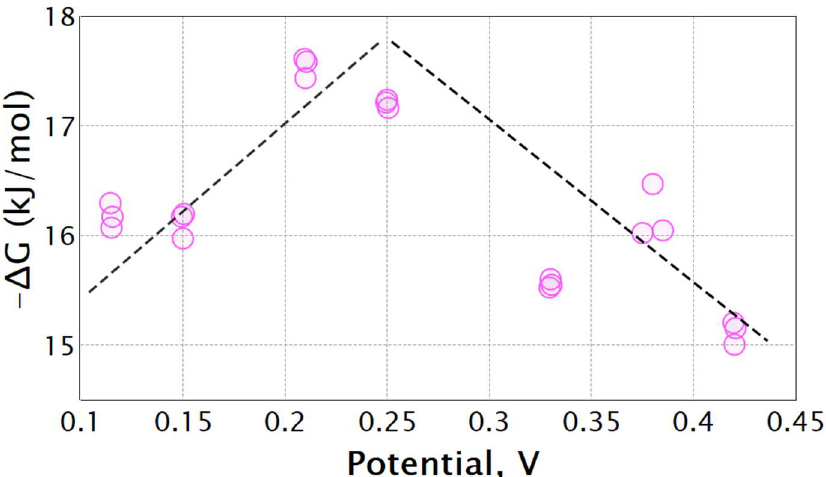
Figure 5. Influence of redox potential on the binding constant of TBA to sorbitol at pH 8.0. Titration conditions: 300 μL of 0.5 mM TBA and 0.3–300 mM of mixtures of K 4 [Fe(CN) 6 ] and K 3 [Fe(CN) 6 ] at various ratios; 25 mM of sorbitol in the titration syringe. The redox potential is indicated vs. Ag/AgCl(sat). The dash lines are drawn to indicate the trend of the data dependence.